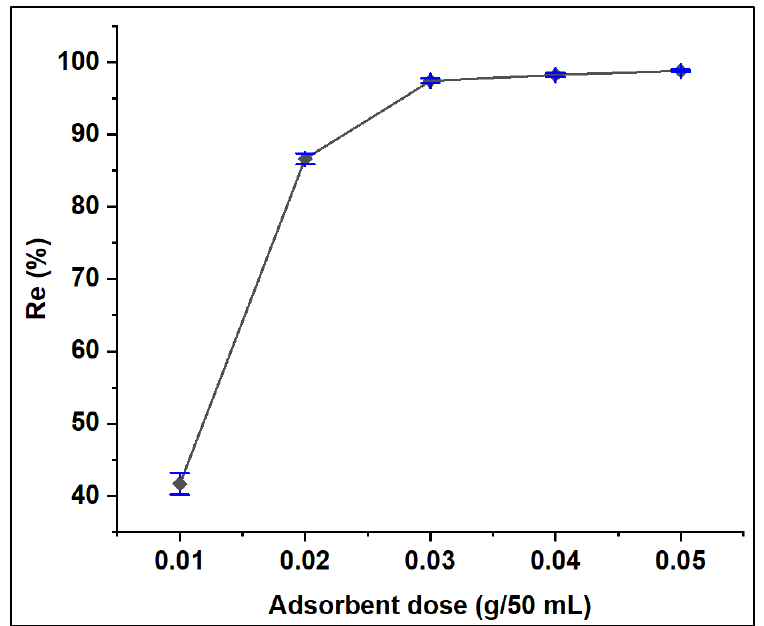
Figure 10. Effect of adsorbent dose on the adsorption of CV onto ZFAC. Bars represent the standard error of the mean ( n = 2).